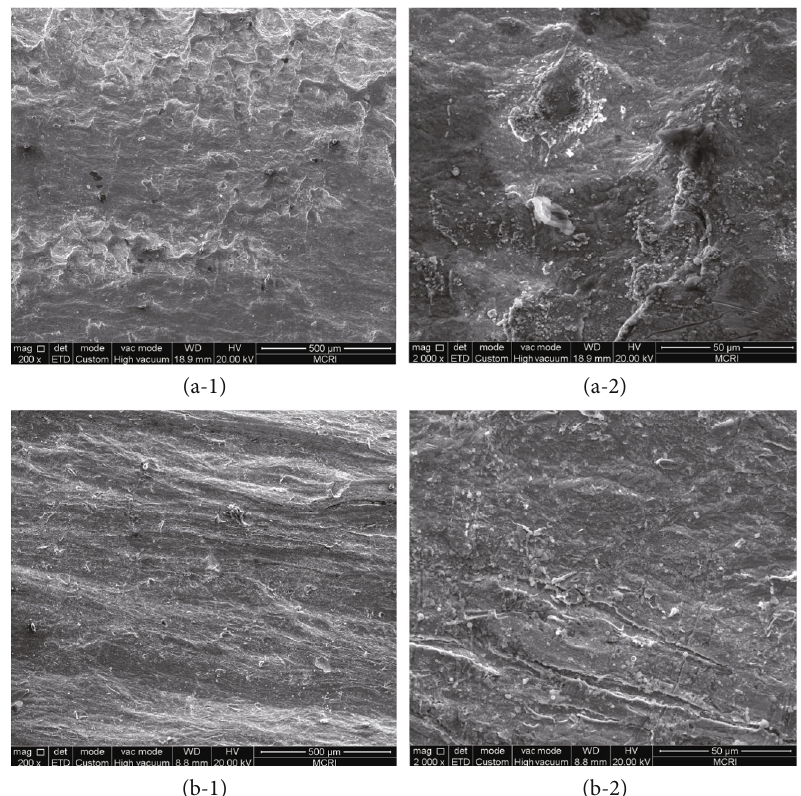
Figure 15: SEM photos of fragments in di ff erent media: (a-1) in the air ( × 200), (a-2) in the air ( × 2000), (b-1) in the water ( × 200), and (b-2) in the water ( ×